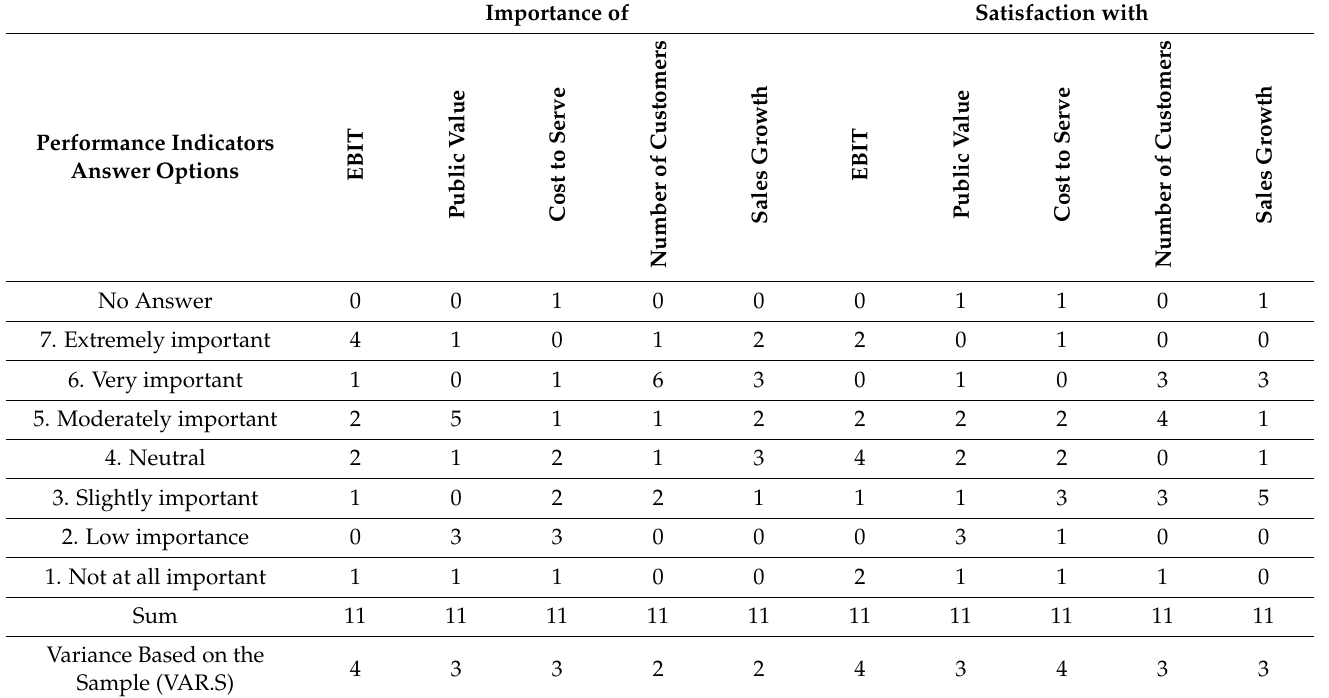
Table 1. Assessment of importance of and satisfaction with performance indicators. Importance of Satisfaction